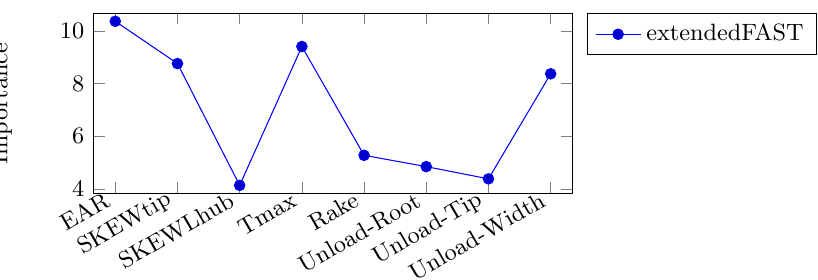
Figure 13. Importance of input parameter according to sensitivity analysis.